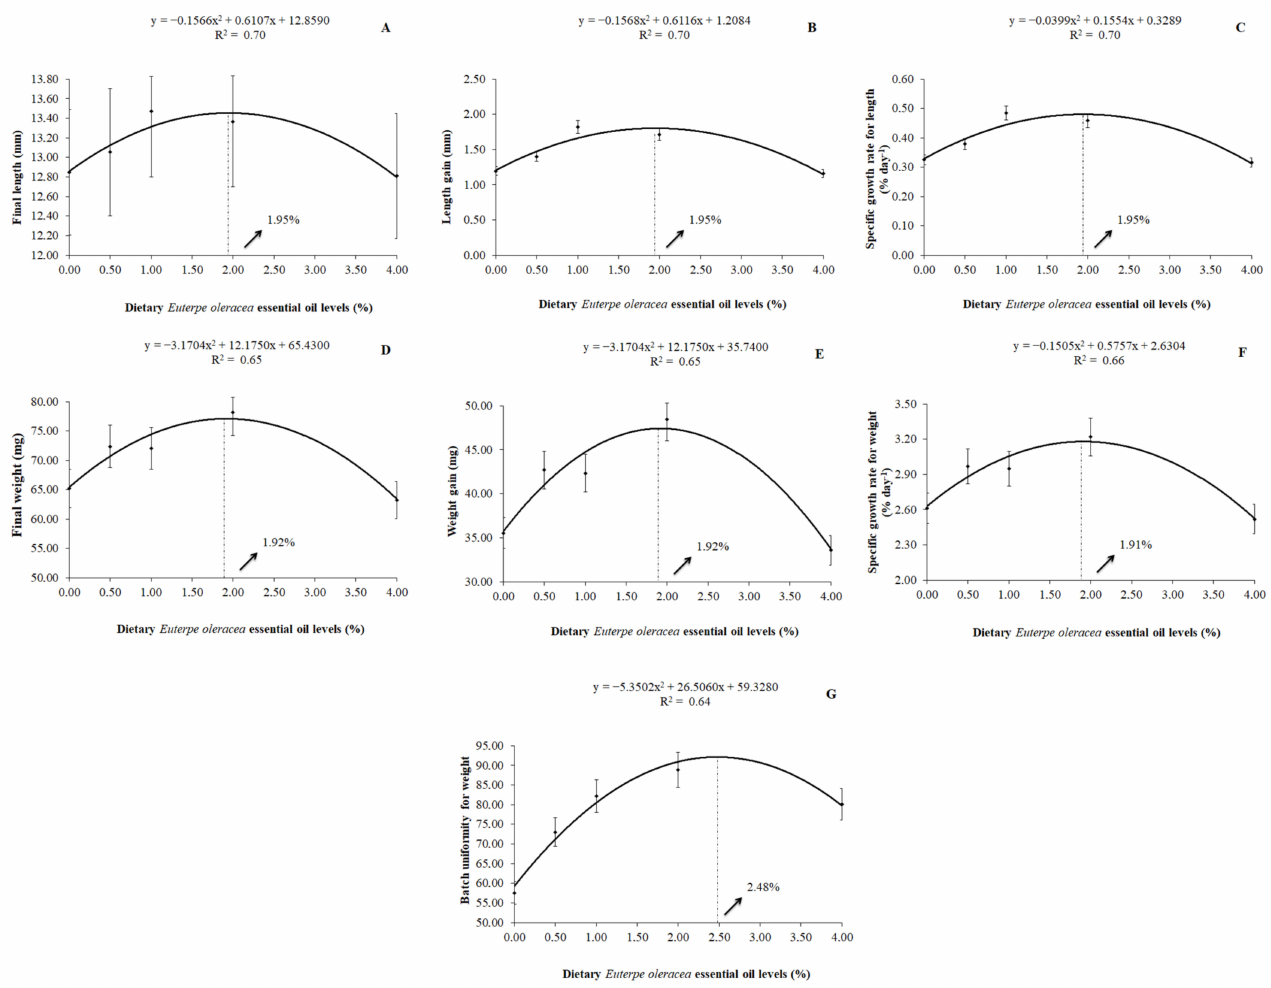
Figure 1. Final length ( A ), length gain ( B ), specific growth rate for length ( C ), final weight ( D ), weight gain ( E ), specific growth rate for weight ( F ), and batch uniformity for weight ( G ) of P. scalare post-larvae fed diets containing levels of dietary Euterpe oleracea essential